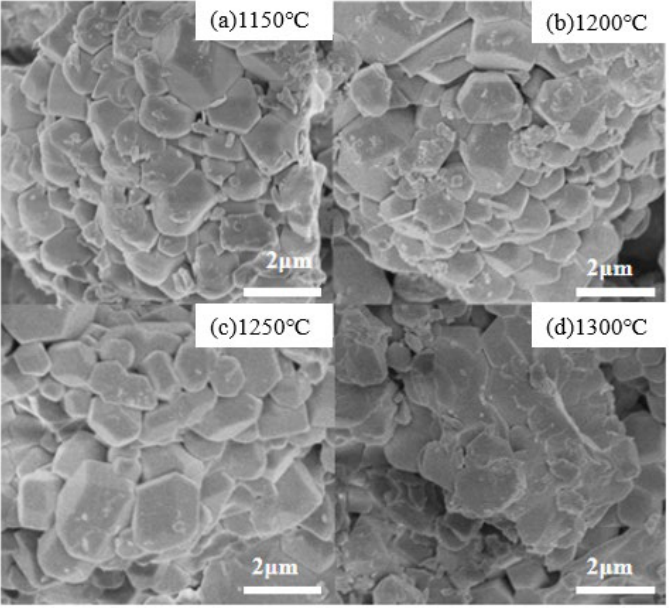
Figure 11. SEM micromorphology of S2 samples at different calcination temperatures.